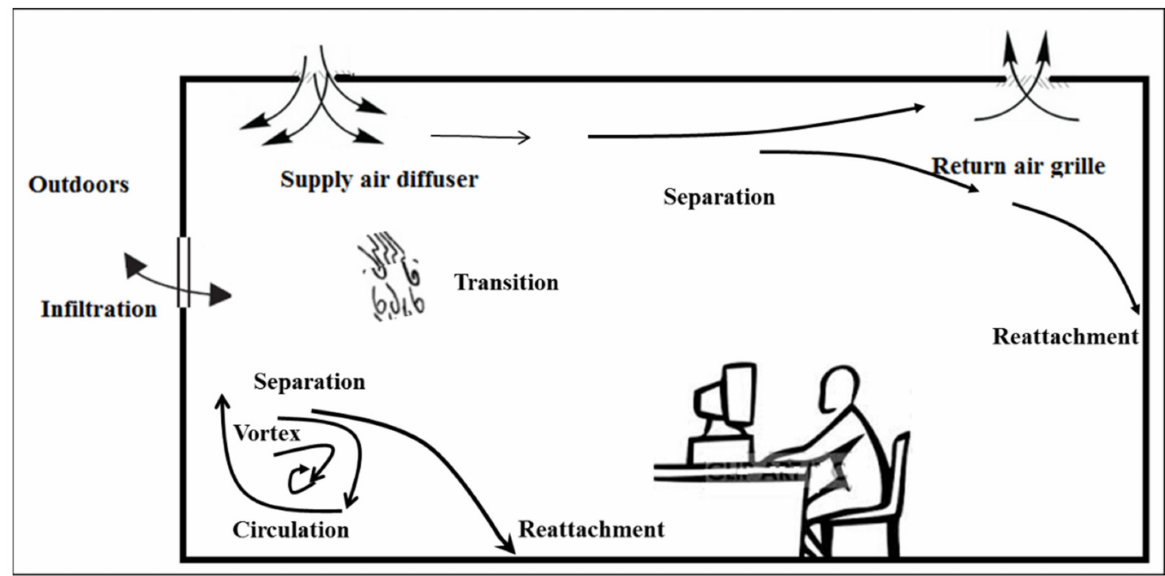
Figure 1. Illustrated airflows in a